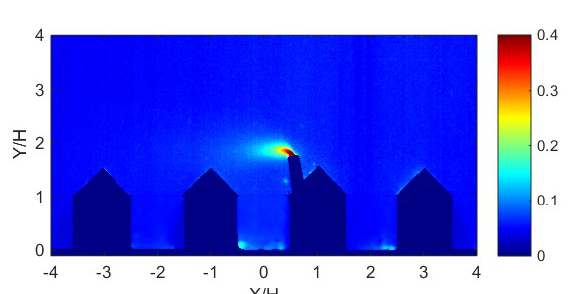
Fig. 17. Mean non-dimensionalised concentration C/C 0 field (C 0 is the mean concentration measured at the top of the chimneystack) for pitched roof and a chimneystack (on the downstream pitch) with h/H = 0.75; the flow moves from the right to the